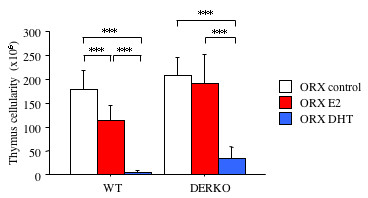
DHT reduces thymus cellularity independently of estrogen receptors. 9-month-old male WT and DERKO mice were orchidectomized and treated for 4 weeks with E2 (0.05 μg/day) or DHT (45 μg/day), administered by s.c. silastic implants. Vehicle animals received empty implants. The E2-mediated reduction of thymus cellularity seen in WT mice, could not be detected in DERKO mice. Treatment with DHT resulted in a dramatic reduction of thymus cellularity independently of ER genotype. One-way ANOVA followed by Fisher's test was used to compare data from mice in different treatment groups. Results are presented as mean ± standard deviation. ***P < 0.001